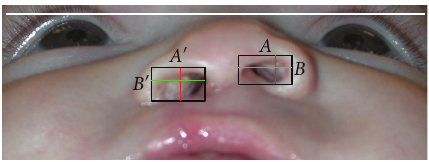
Figure 1: Nostril height and width ratio = the nostril height and width ratio on the cleft side ( A (cid:3) / B (cid:3) )/the nostril height and width ratio on the noncleft side ( A / B ). For clarification of Figure 1, in this study A (cid:3) was cleft side width, B (cid:3) was cleft side height, A was noncleft side width, and B was noncleft side height.